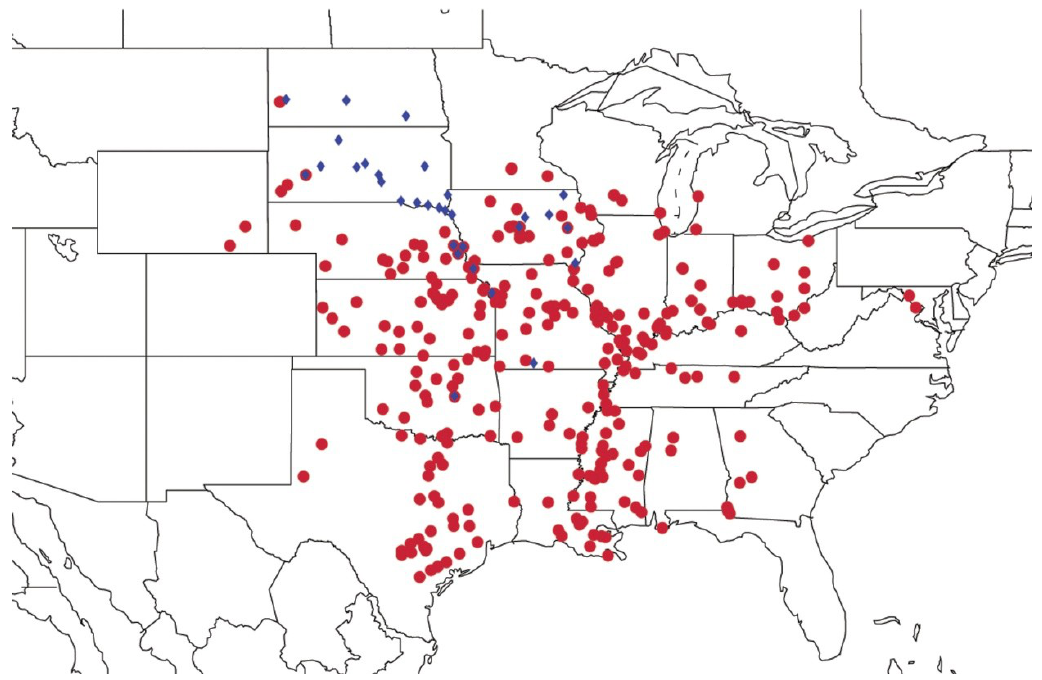
Figure 21. Distribution of Tibicen pronotalis pronotalis (blue diamonds) and T. pronotalis walkeri (red